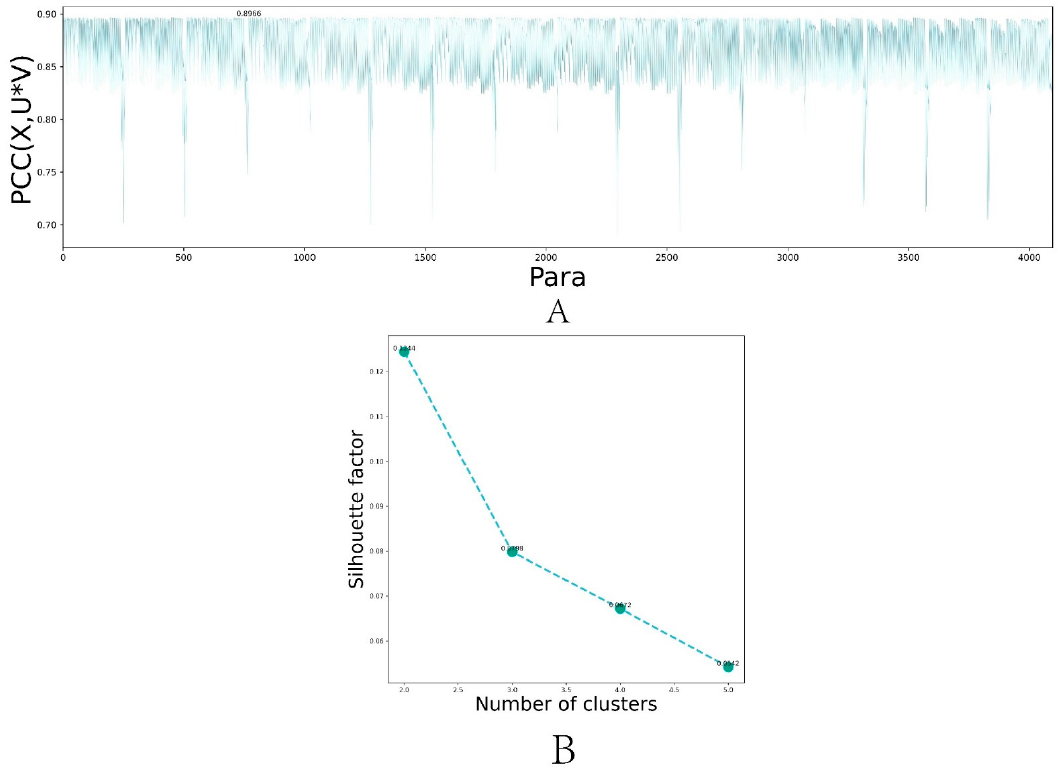
Figure 2. Variation trend of hyperparameter selection and function values of different constraint terms with the increasing number of iterations for DL-ONMF algorithm. ( A ) Line plot of the reconstruction performance of the algorithm under different parameter combinations. ( B ) Line plot of the reconstruction performance of the algorithm for different values of 𝑘 .